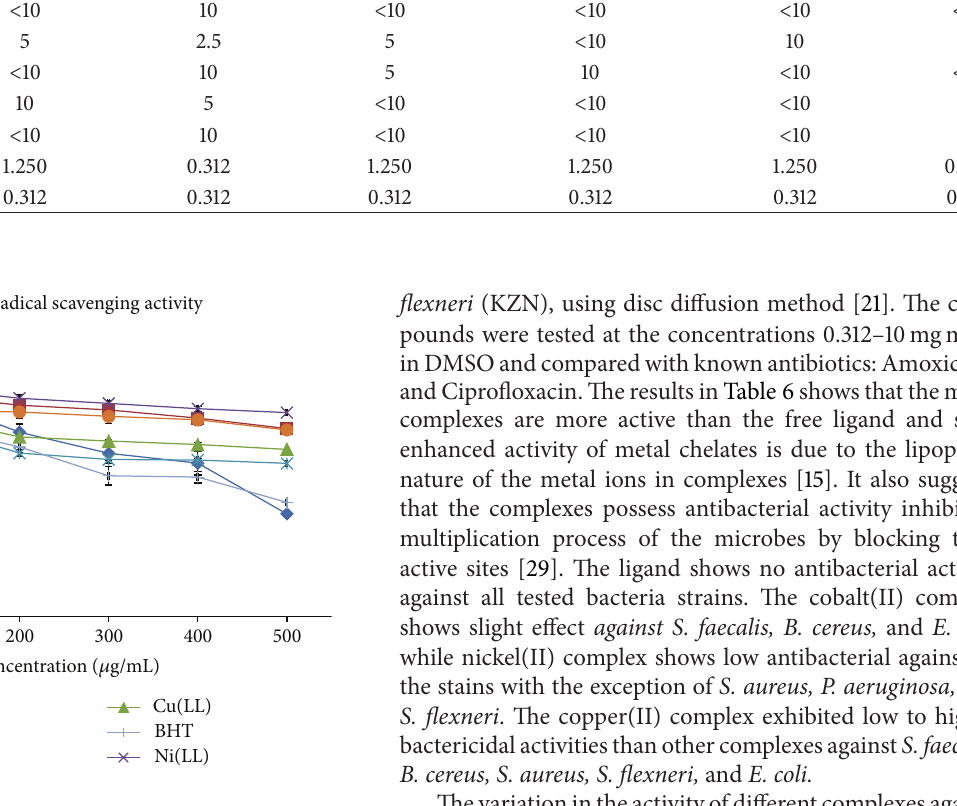
Table 6: Minimum inhibitory concentration values (mg/mL) of the Schiff base ligand [ H Gram-positive bacteria Compounds